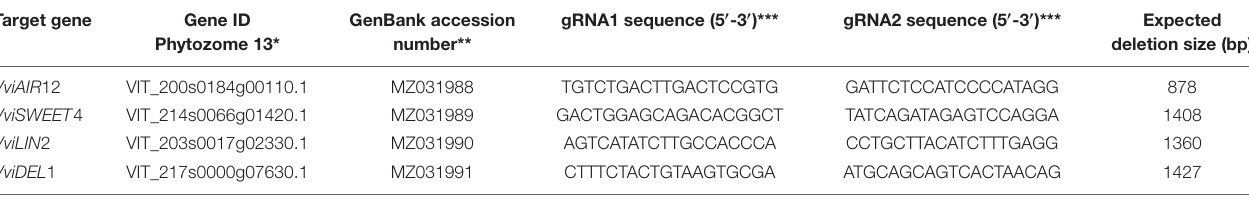
FIGURE 2 | Design and construction of universal geminivirus-based vector for the expression of multiple guide RNAs. (A) The geminivirus-based universal vector (pGMV-U) was assembled by linking four DNA fragments through a Gibson assembly reaction. The fragment carrying the sequence required for the insertion of multiple gRNAs was amplified from the pHSE401 plasmid while the three remaining fragments containing sequences for the LSL replicon were located within an Agrobacterium T-DNA sequence. The binary vector backbone was amplified from the pTC223 plasmid. Arrows indicate the primers used for the fragment amplifications. Dotted lines indicate the overlapping sequences between fragments required for the assembly reaction. Scissor icons indicate the Bsa I sites. (B) Resulting pGMV-U vector map: T-DNA RB, right border of the Agrobacterium T-DNA; LIR, large intergenic region from the Bean yellow dwarf virus (BeYDV); 35S, 35S CaMV promoter from Cauliflower mosaic virus; AtCas9, Cas 9 Arabidopsis thaliana codon usage; HSP t, terminator for heat shock protein 18.2 (HSP) from A. thaliana ; U6-26p, A. thaliana U6-26 RNA pol III promoter; Spe R , spectinomycin resistance gene; gSc, gRNA scaffold sequence; U6-26t, A. thaliana U6-26 RNA pol III terminator; SIR, short intergenic region from BeYDV; Rep/RepA, nucleotide sequence for the Rep / Rep A replication genes; LB T-DNA, left border of the Agrobacterium T-DNA. TABLE 1 | Targeted genes in this work and selected guide RNA couples used for their inactivation. Target